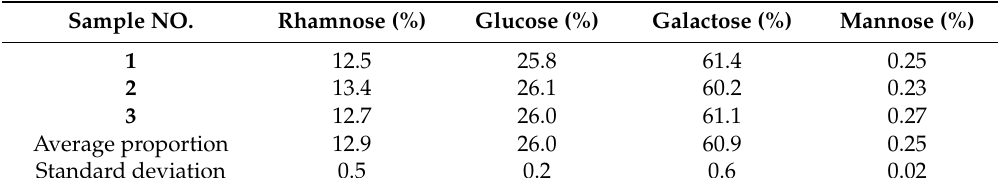
Table 1. The monosaccharide composition of the EPS-1.